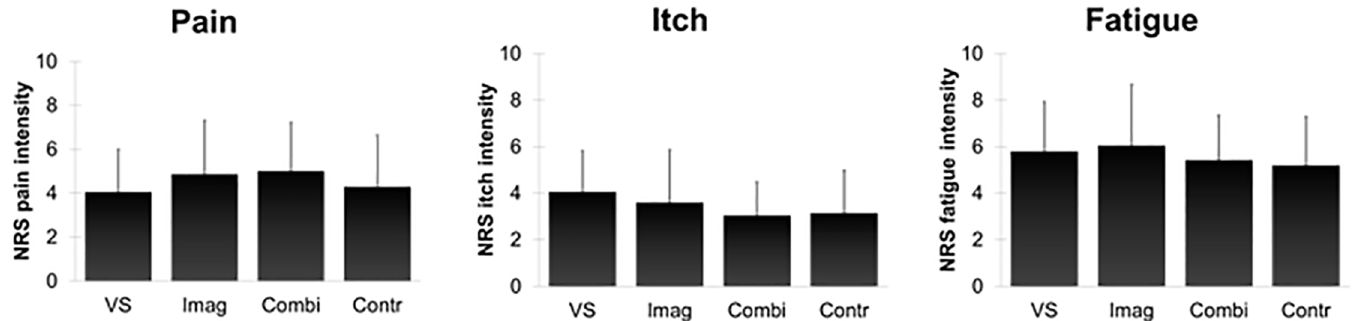
Fig 1. Means and standard deviations of NRS intensity scores for pain, itch, and fatigue during the respective tests. VS = Verbal suggestion condition; Imag = Imagery condition; Combi = Combination condition; Contr = Control condition. Error bars represent standard